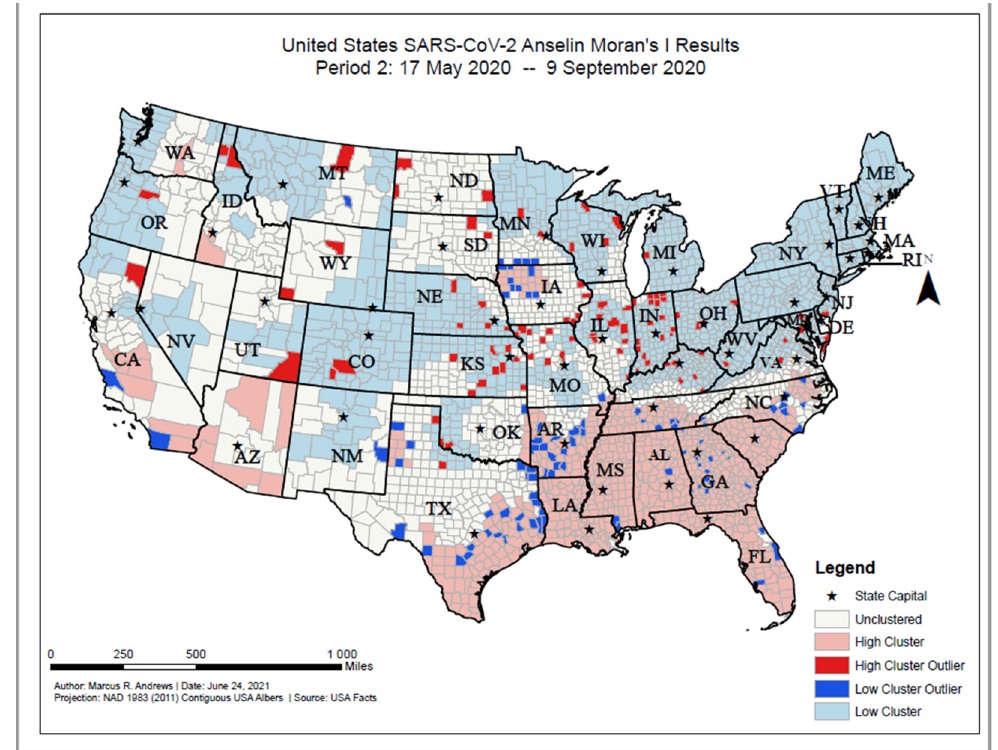
Figure 6. United States SARS-CoV-2 Anselin Moran’s I results, Period 2: 17 May 2020–9 September 2020. As of 4 January 2021, high COVID-19 incident proportion clusters were primarily located in the central U.S. and included North and South Dakota, Minnesota, Wisconsin, Illinois, Indiana, Nebraska, Kansas, Oklahoma, Missouri, Montana, Wyoming, Arkansas, Tennessee, and Texas (Figure 7). Low incident clusters were located primarily along the coastal regions of the U.S., stretching from Maine to Florida westward through Georgia, Louisiana, and southeastern Texas. Low incident clusters were also located from Washington state to central California. High incident outlier counties were located primarily in Alabama, South Carolina, eastern Texas, and northern California. Low incident outlier counties were primarily located in the central U.S., stretching from the Dakotas to the north, Montana to the west, western Ohio to the east, and western Texas to the South. As of 30 April 2021, high COVID-19 incident proportion clusters were primarily located along the eastern U.S, ranging from southern New Hampshire to South Carolina. High incident proportion clusters were also located in Kentucky, Michigan, northeastern Tennessee, Oklahoma, Texas, and eastern Arizona (Figure 8). Low incident proportion clusters were primarily located in the western U.S., including Washington, Oregon, northern California, Nevada, New Mexico, Montana, and Idaho. Low incident proportion clusters were also located in the Dakotas, Nebraska, Kansas, Iowa, southern Kansas, Wisconsin, Minnesota, and Georgia. High incident outlier counties were located primarily in Nebraska, Iowa, Washington, Idaho, Colorado, and Texas. Low incident outlier counties were located primarily in Texas, Oklahoma, Tennessee, the Carolinas, Virginia, and Pennsylvania.